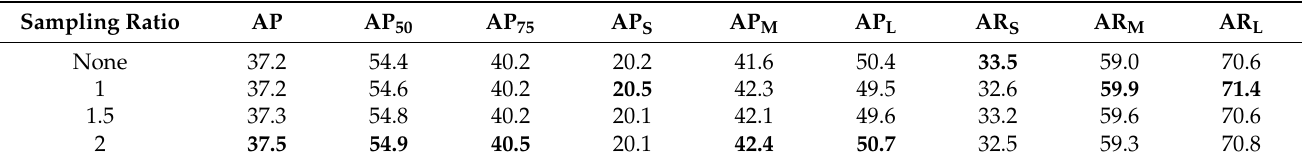
Table 3. The results of different center sampling ratio on the MS COCO minival set. Bold font indicates the best